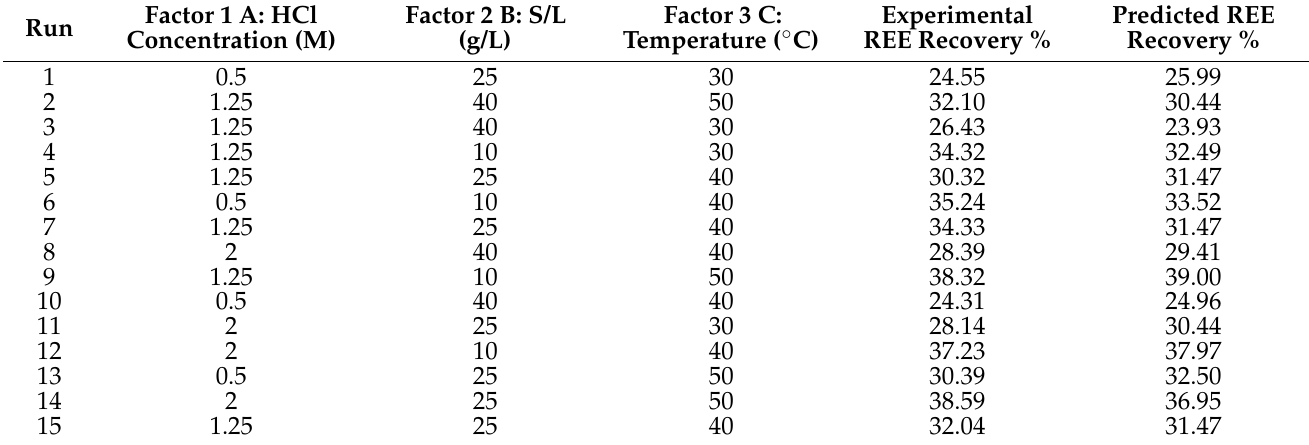
Table 4. Experimental vs. predicated % REE leaching recovery from